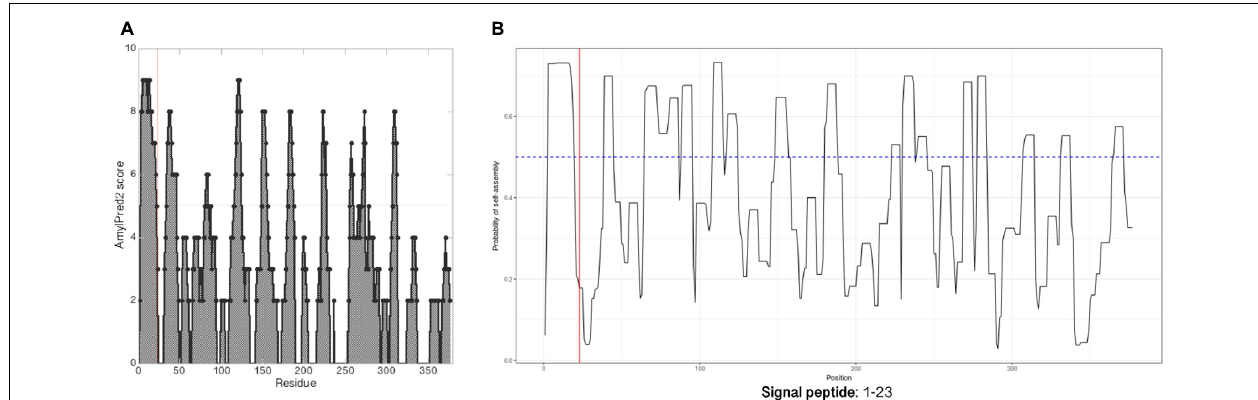
FIGURE 3 | MspA has regularly spaced amyloidogenic regions. Analyzing the MspA (WP_011449234.1) sequence with (A) AmylPred2 (Tsolis et al., 2013) and (B) AmyloGram (Burdukiewicz et al., 2017) revealed several regions of predicted high amyloidogenicity (above the horizontal lines). The red, vertical lines indicate the signal peptide cleavage site position.